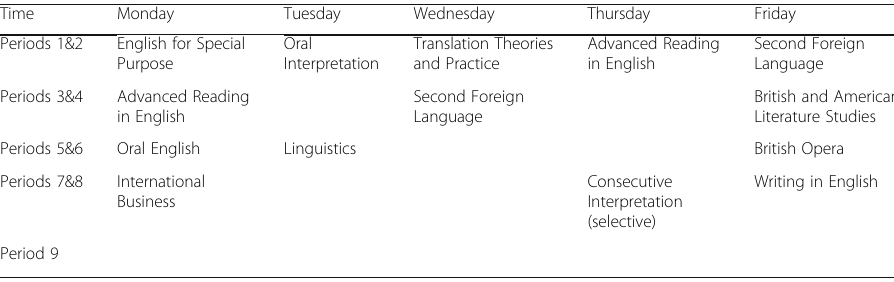
Table 3 The fifth-term timetable for English major students